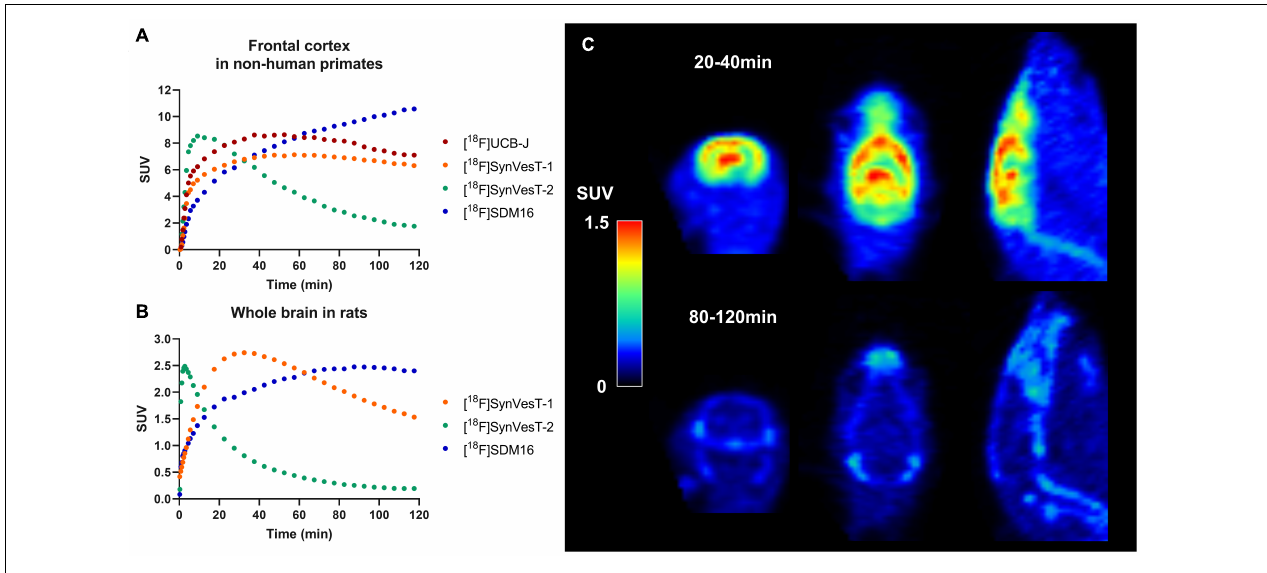
FIGURE 1 | Tracer kinetics for 18 F labeled SV2A tracers in rhesus macaques and rats. (A) Representative time activity curves (TACs) for [ 18 F]UCB-J, [ 18 F]SynVesT-1, [ 18 F]SynVesT-2, and [ 18 F]SDM-16 in frontal cortex of rhesus macaques from different subjects. (B) Representative TACs for [ 18 F]SynVesT-1, [ 18 F]SynVesT-2, and [ 18 F]SDM-16 in whole brain of rats. (C) [ 18 F]SynVesT-2 20–40 min (top) and 80–120 min (bottom) summed images in a wild-type Sprague–Dawley rat. The 20–40 min summed image shows high uptake in the brain while the 80–120 min image shows tracer uptake in skull and spine. The bone uptake at later time windows suggests